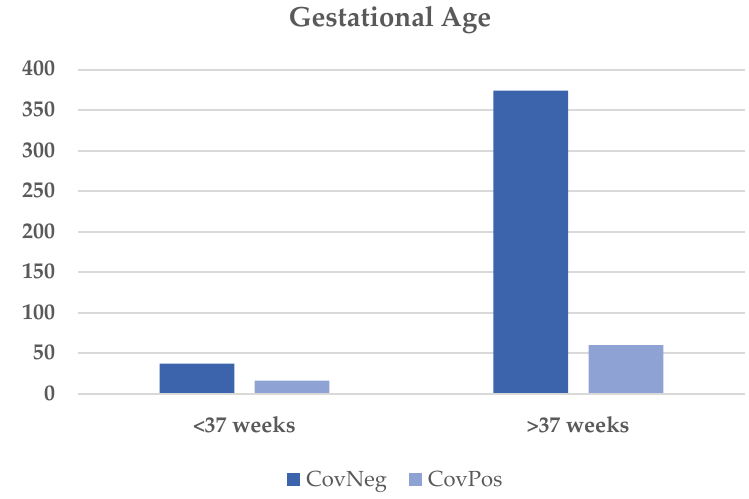
Figure 3. Gestational age at delivery between CovNeg and CovPos groups. For the infants, there were no significant differences in the sex of the child, one- and five-minute APGAR scores, frequency of small for gestational age or symmetrically small for gestational age infants, or admission to the newborn nursery versus the NICU or ICN, as shown in Table 3. Distributions of birthweight categories were not the same between the two groups ( p = 0.01), with LGA infants more common in the CovPos (12%) than in the CovNeg (3%, p = 0.001) group (see Table 3). Table 3. Infant demographics between CovPos and CovNeg groups.